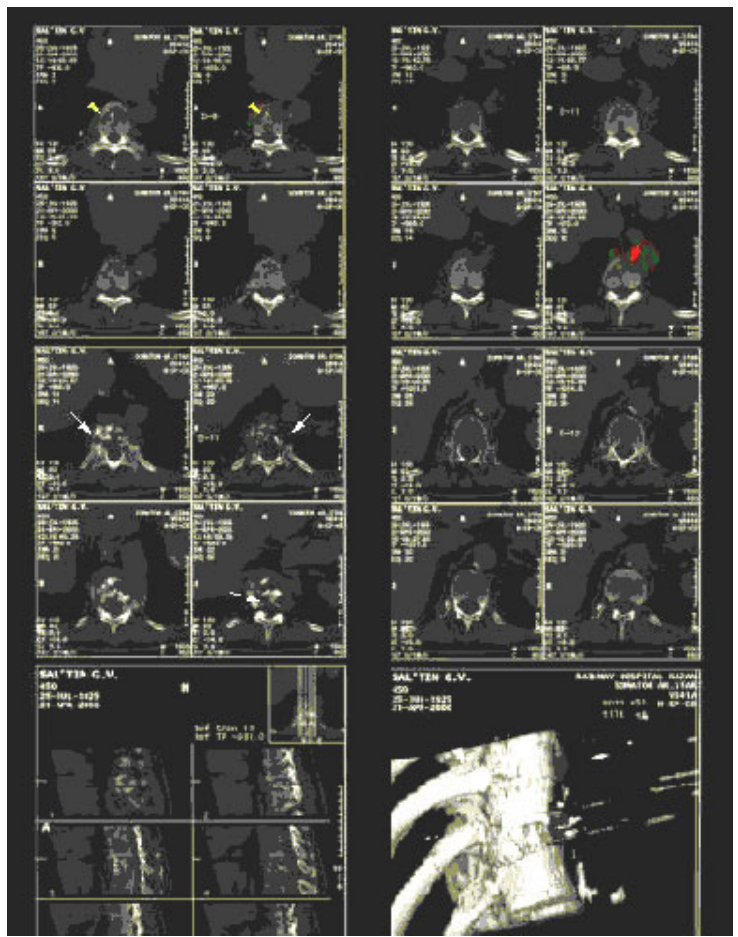
FIGURE 1 . MRIs of patient with backbone metastases (before treatment with bacteria). Compression fracture of the Th.XI. vertebral body with wedge-shaped deformity and slight consequent kyphosis are detected. There are sclerotic bony fragments, but the presence of lytic process is also evident; this is most conspicuous in the vertebral arches. Surrounding soft tissues are somewhat widened. There is another lytic area (approximately 1.5 × 2.5 cm) on the left anterior aspect of Th.X. vertebral body adjacent to Th.X. intervertebral space, affecting the cortical bone as well. A third lytic area is demonstrated in Th.IX. Vertebral body on the right side with a size of approximately 1 × 2.5 cm. It has lobulated contours with sclerotic margins. There are moderate sclerotic degenerative appositions at the Th.XI. facet joints. There is no significant spinal canal stenosis at this point. Lytic areas in Th.XI. vertebra, involving the arches: white arrows; lytic lesion in Th.IX. vertebral body with sclerotic margin: short yellow arrow; lesion in Th.X. vertebral body at its lower rim: red